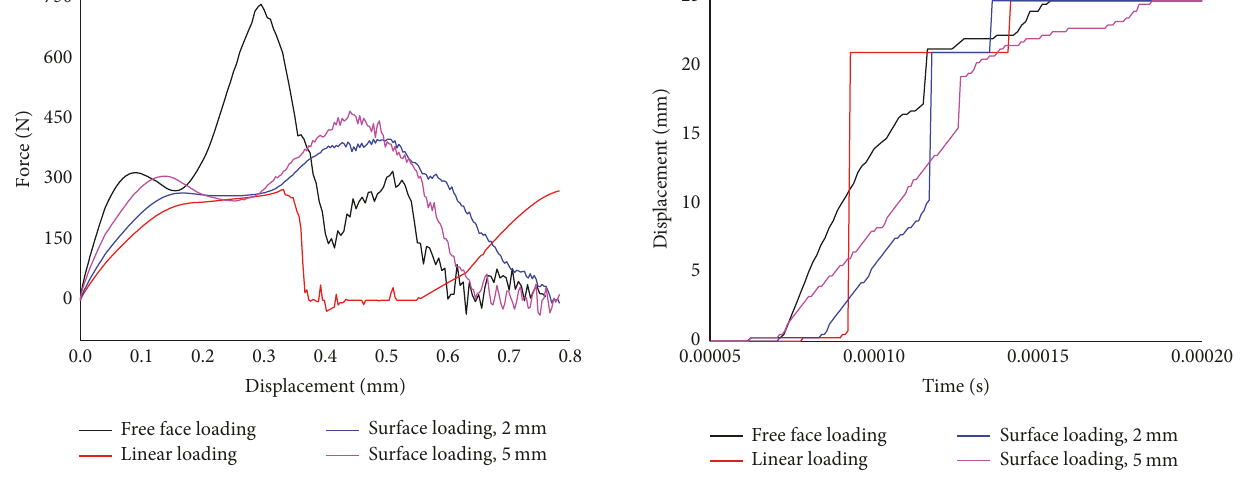
Figure 18: Displacement-loading curve. Figure 19: Displacement-time